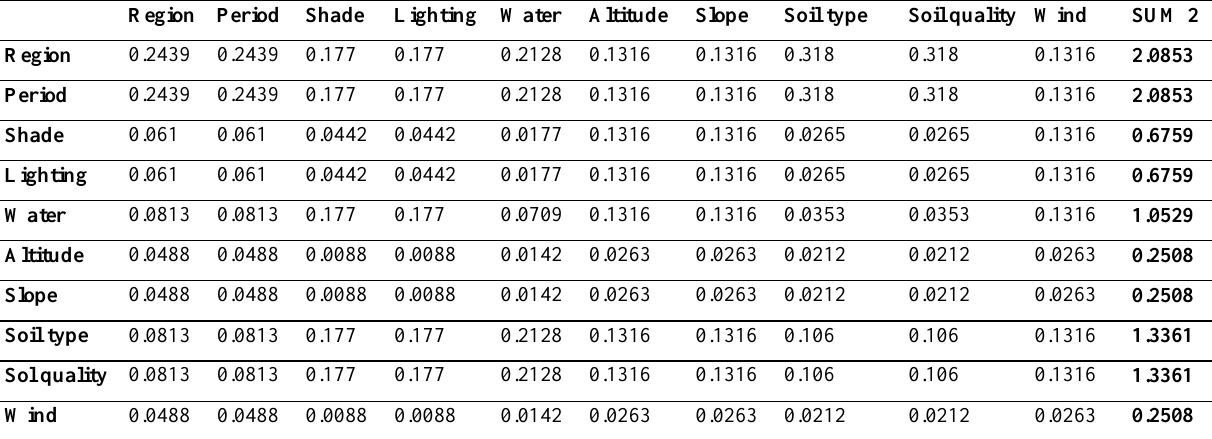
Table 3. Standardized comparison matrix (Matrix 2)